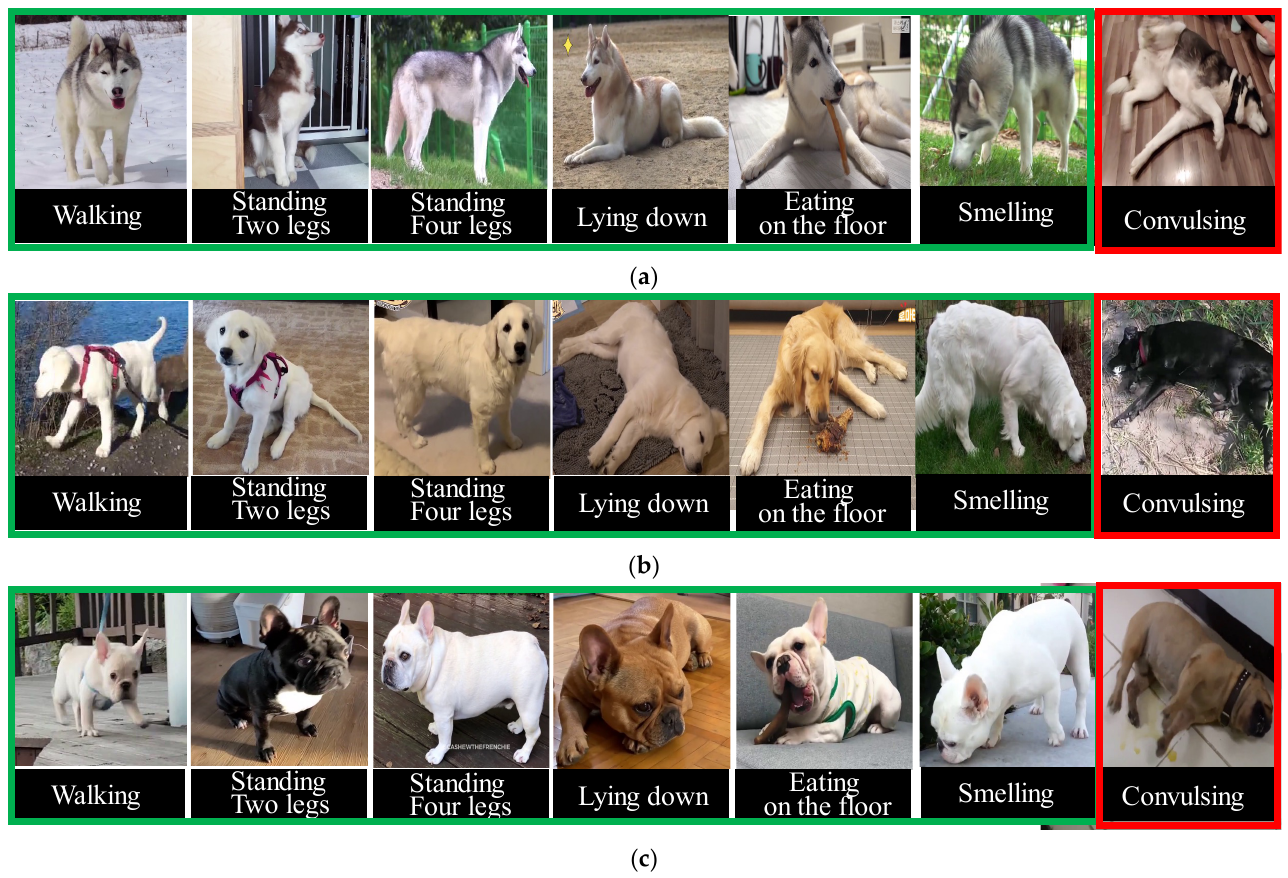
Figure 3. Some samples from the Youtube-C7B dataset. ( a ) Siberian Husky, ( b ) Retriever and ( c ) French Bulldog